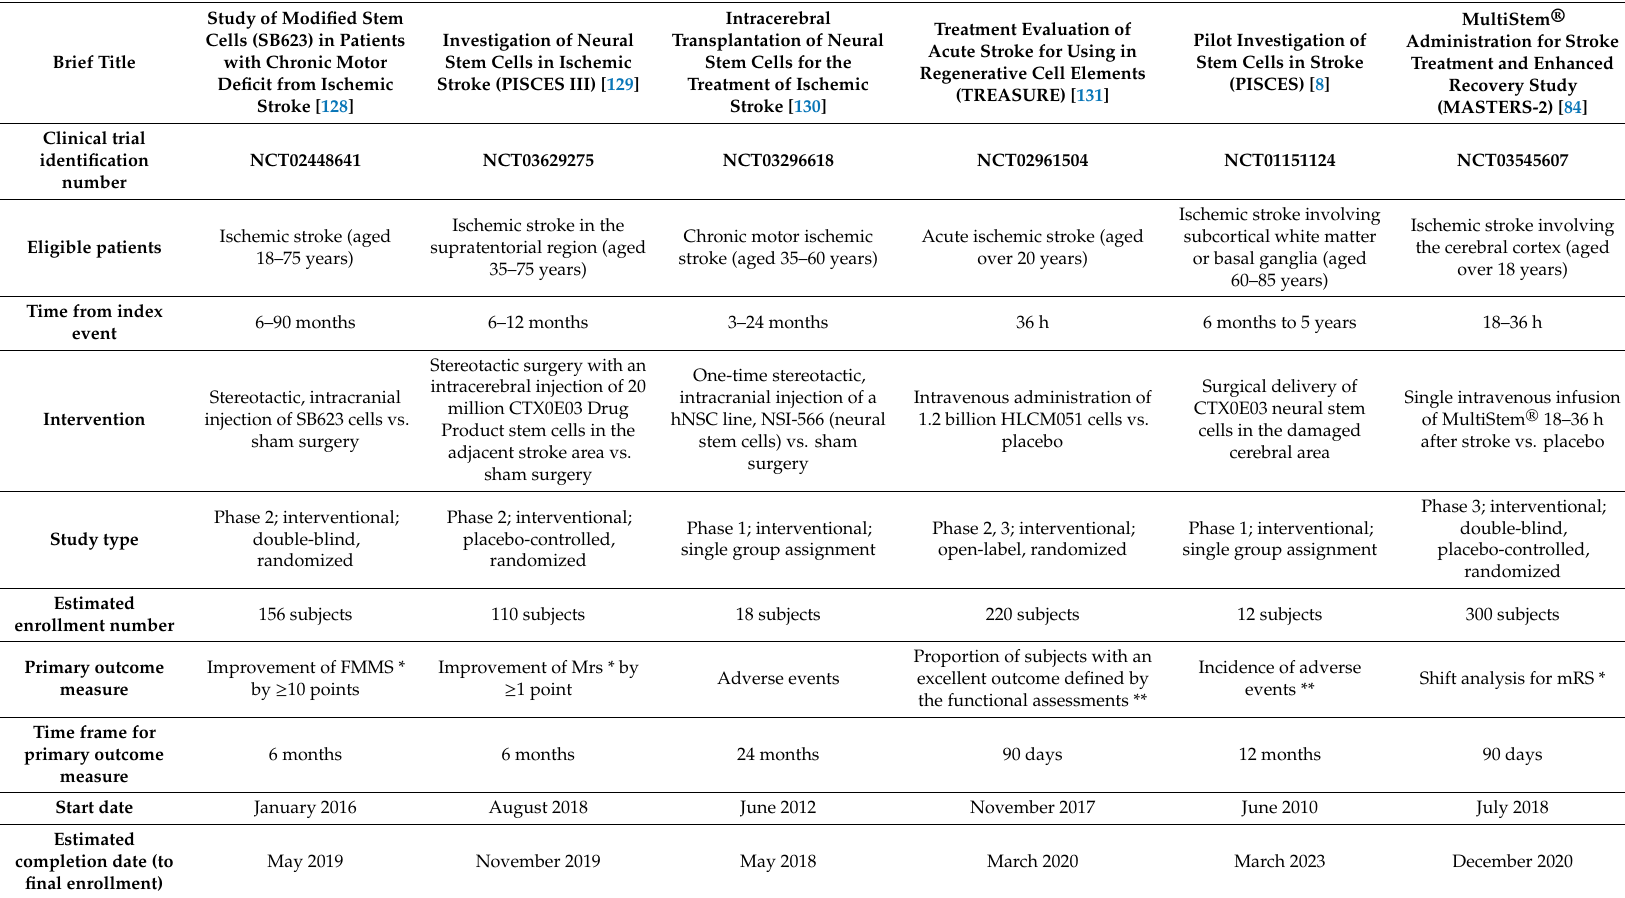
Table 2. Ongoing registered clinical trials for various deliveries of stem cells in patients with ischemic